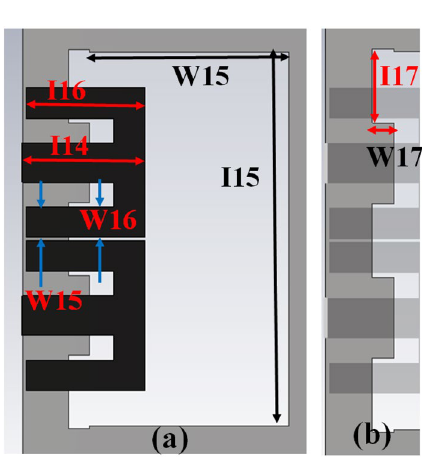
Figure 12. Detail dimensions of Ant 1–4 ( a ) top, and ( e ) ground structure.